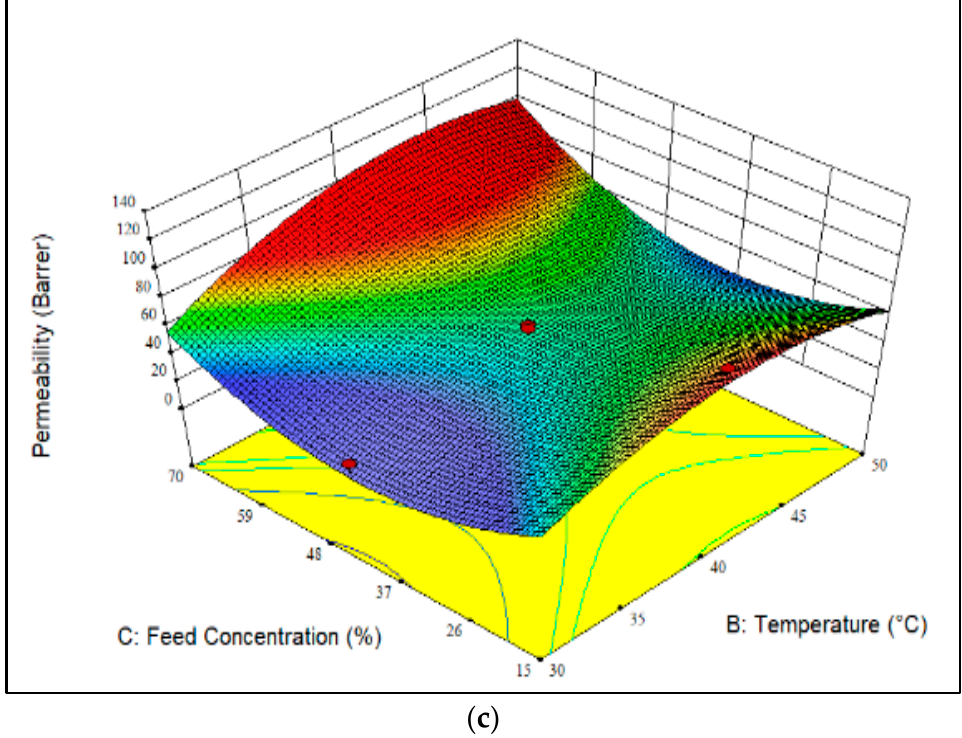
Figure 2. CH 4 permeability as a function of feed pressure, CO 2 feed concentration and temperature at ( a ) CO 2 feed concentration of 42.5 mol%, ( b ) temperature of 40 °C and ( c ) feed pressure of 8 bar. (The darker color (red) represents higher membrane performance whereas the lighter color (blue) indicated lower membrane performance.)